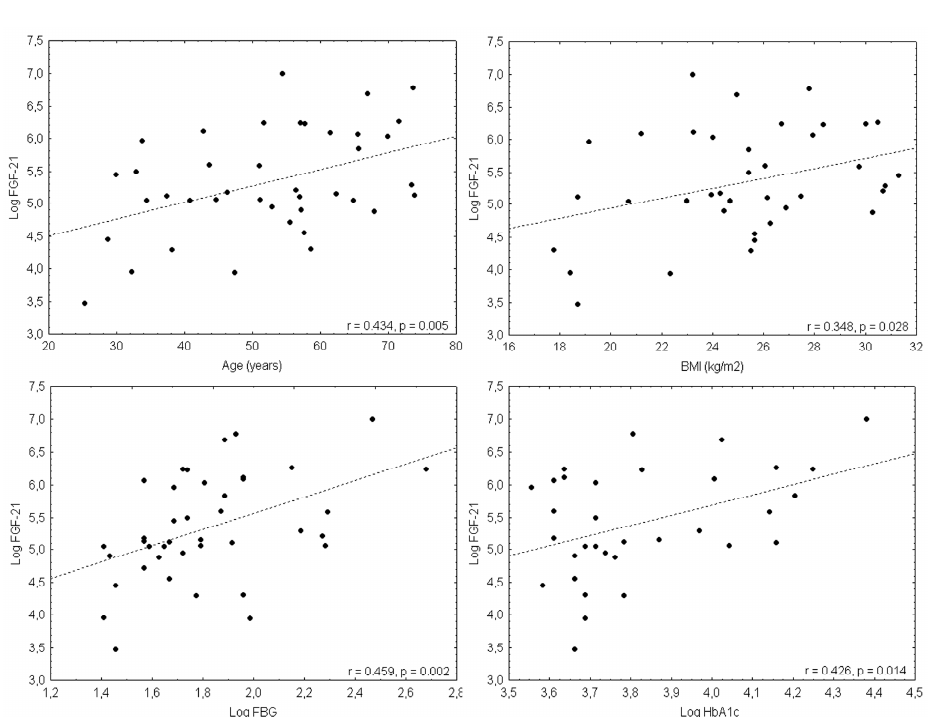
Figure 1. FGF21 levels and their correlation with selected factors in PPGL—age, BMI, FBG a HbA1c.